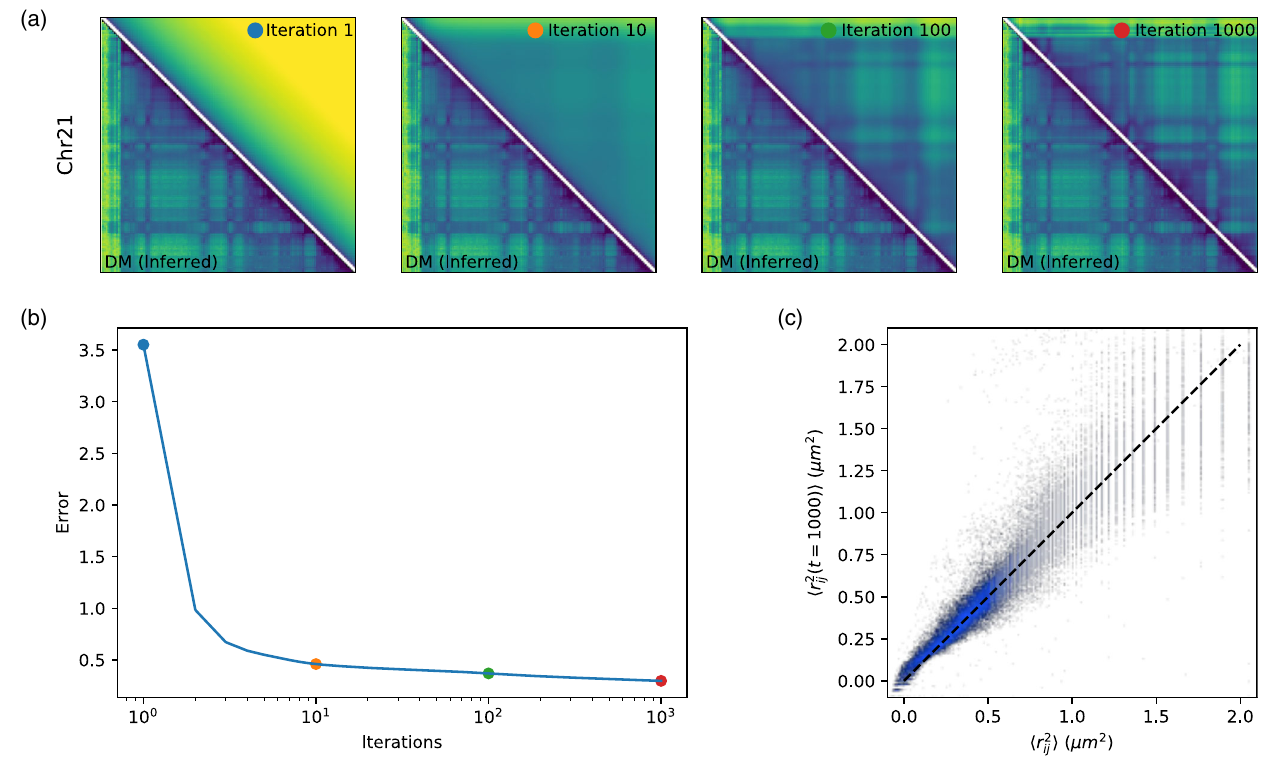
FIG. 11. (a) Comparison between the targeted distance matrix (lower triangle) and the distance matrix at different iteration steps. At iteration step 1000, we achieve good agreement with targeted distance matrix. (b) The error as a function of iteration steps. The error is defined as the L2 norm between targeted distance matrix and simulated distance matrix. (c) The scatter plot between targeted h r 2